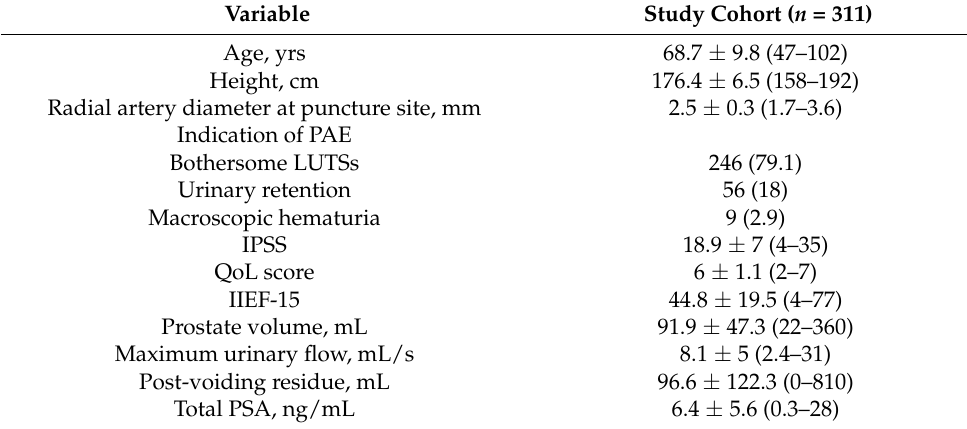
Table 1. Baseline characteristics of the study